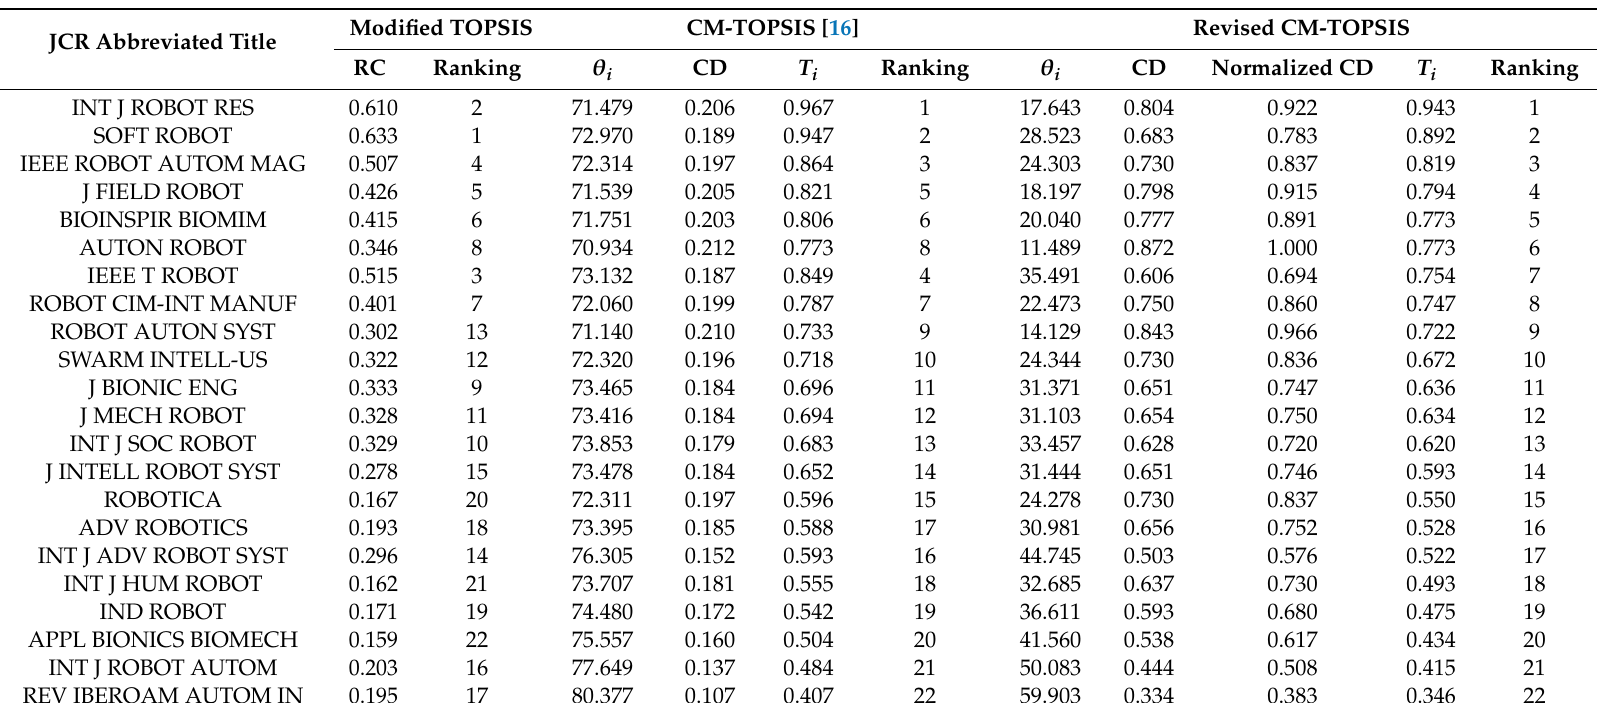
Table 2. Evaluation results of modified Technique for Order Preference by Similarity to Ideal Solution (TOPSIS), coordinated modified (CM)-TOPSIS, and revised